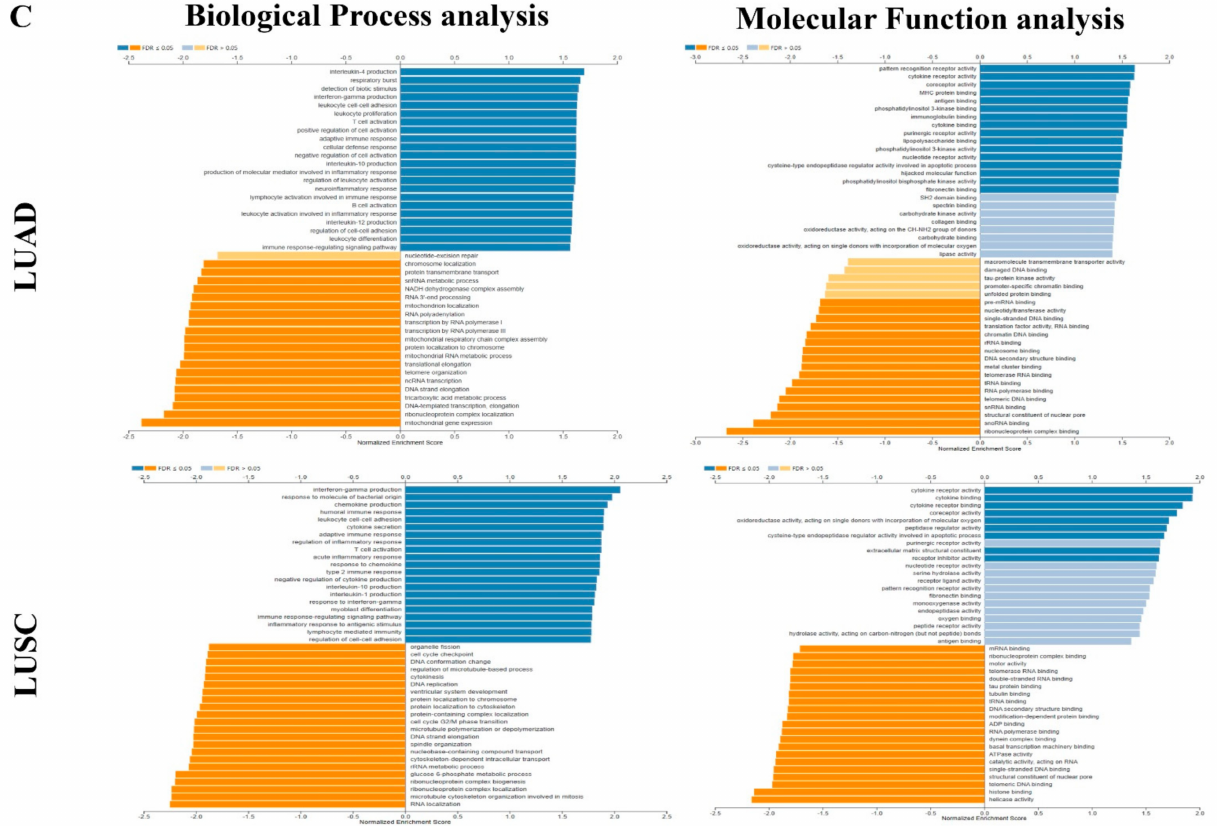
Figure 4. Biological interaction network of LPAR6. LPAR6 interaction network in TCGA, different colors represent diverse bioinformatics methods ( A ) and differentially expressed genes in correlation with LPAR6 and heat maps of positively and negatively correlated genes with LPAR6 in LUAD and LUSC were analyzed by Pearson test ( B ). Enriched gene ontology annotations of biological process and molecular function analysis of LPAR6 correlated genes in LUAD and LUSC ( C ). Red indicates positive and blue indicates negative. Dark blue and orange indicate FDR ≤ 0.05, light blue and orange indicate FDR > 0.05. FDR, false discovery